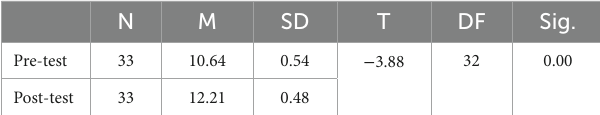
TABLE 1 Paired-samples T -test for pre-test and post-test.